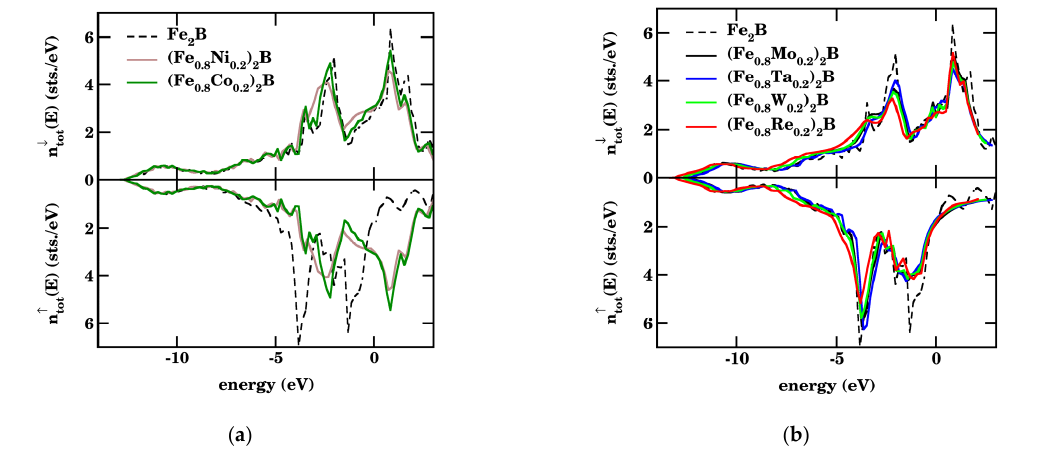
Figure 2. ( a ) The density of states (DOS) of 3d -doped (Fe 0.8 M 0.2 ) 2 B alloys (M = Co, Ni) and ( b ) the density of states (DOS) of 4d - and 5d -doped (Fe 0.8 M 0.2 ) 2 B alloys (M = Mo, Ta, W and